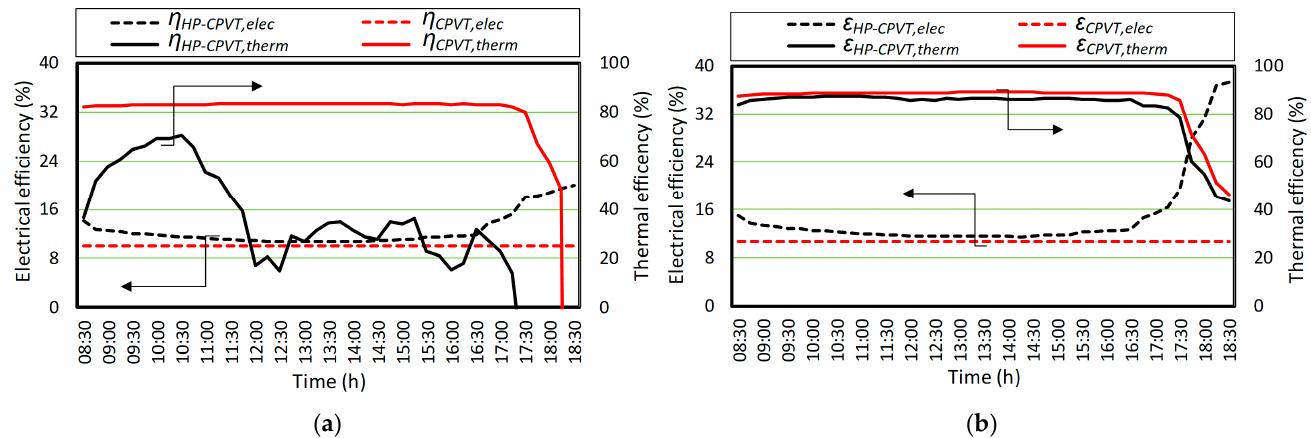
Figure 12. Changes in the electrical and thermal efficiencies of ( a ) energy and ( b ) exergy for both systems according to Equations (31)–(36).